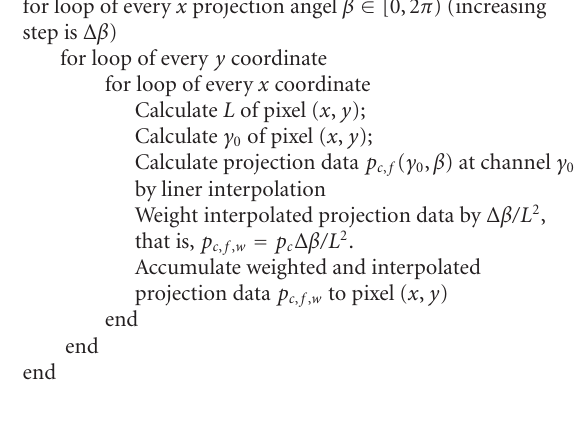
Algorithm 1: Pseudocode for the